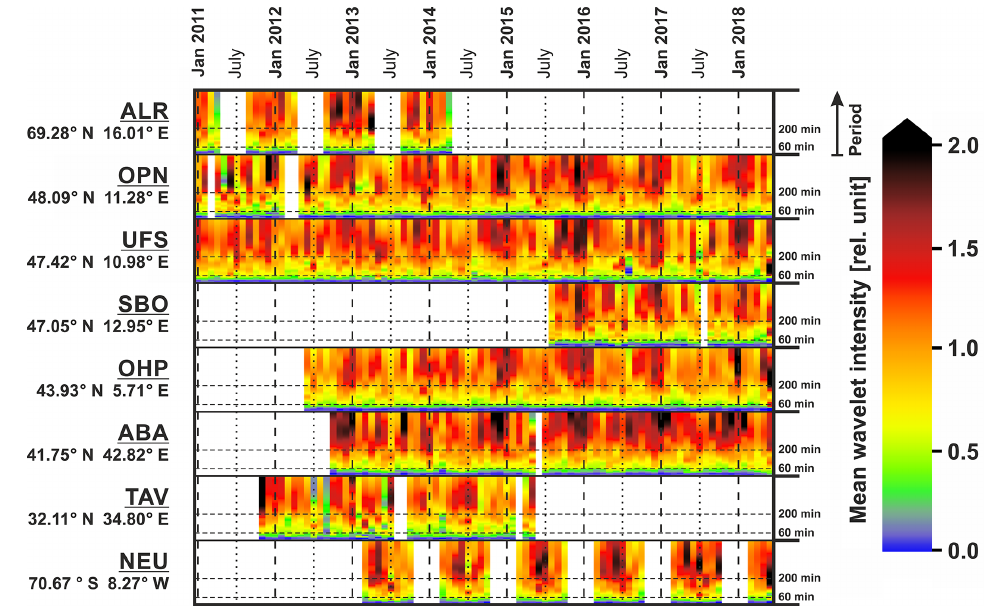
Figure 2. Monthly-mean wavelet intensity in the period range between 6 and 480min for different observation sites.